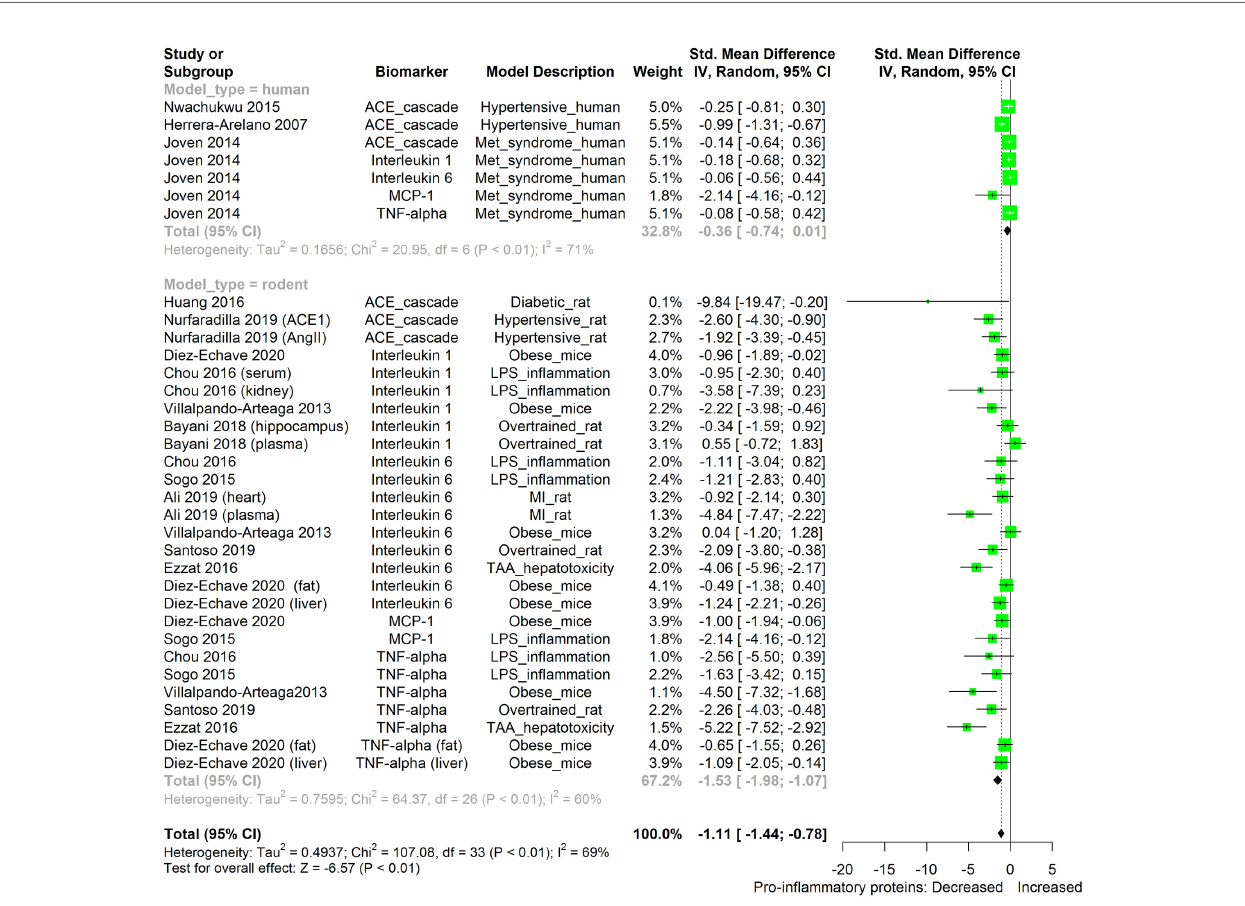
FIGURE 12 | Meta-analysis and forest plot of the effect of HS administration on selected pro-in fl ammatory biomarkers (ACE, TNF- a , IL-6, IL-1 b , MCP-1) from diseased human and rodent models. The meta-analysis was sub-grouped by model organism (i.e diseased human or diseased rodents models). The standardized mean difference (SMD), which is an estimate of the effect size, is presented as a square on the forest plot, for each study and as a diamond for the pooled estimate of each subgroup or overall studies. The overall pooled SMD for all included studies is shown in the bottom section of the forest plot. SMD data points that are lower than zero signify that treatments with HS lowered the level of the biomarker while those greater than zero signify that HS treatment causes an increase in the levels of biomarker. The statistical signi fi cance of the pooled estimate is indicated by the Z test of signi fi cance. MI, Myocardiac infarction; LPS, Lipopolysaccharide; TAA, Thioacetamide; Met, Metabolic; TNF-alpha, Tumour necrosis factor-alpha; MCP-1, Monocyte chemoattractant protein-1; ACE, Angiotensin-converting